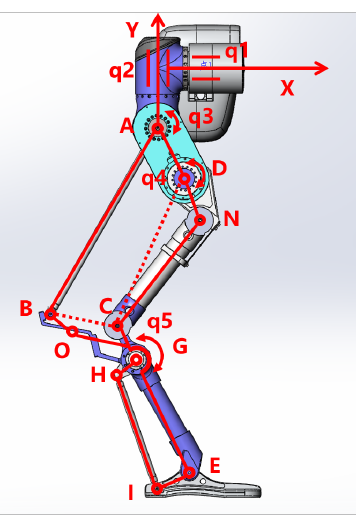
Figure 2. Side view and mechanism diagram of biped robot simulation